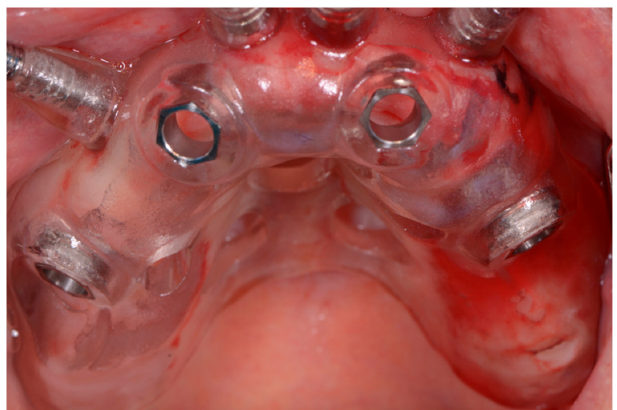
Int. J. Environ. Res. Public Health 2021 , 18 , x Figure 8. Surgical template positioned and fixed in the oral cavity. Figure 8. Surgical template positioned and fixed in the oral cavity.